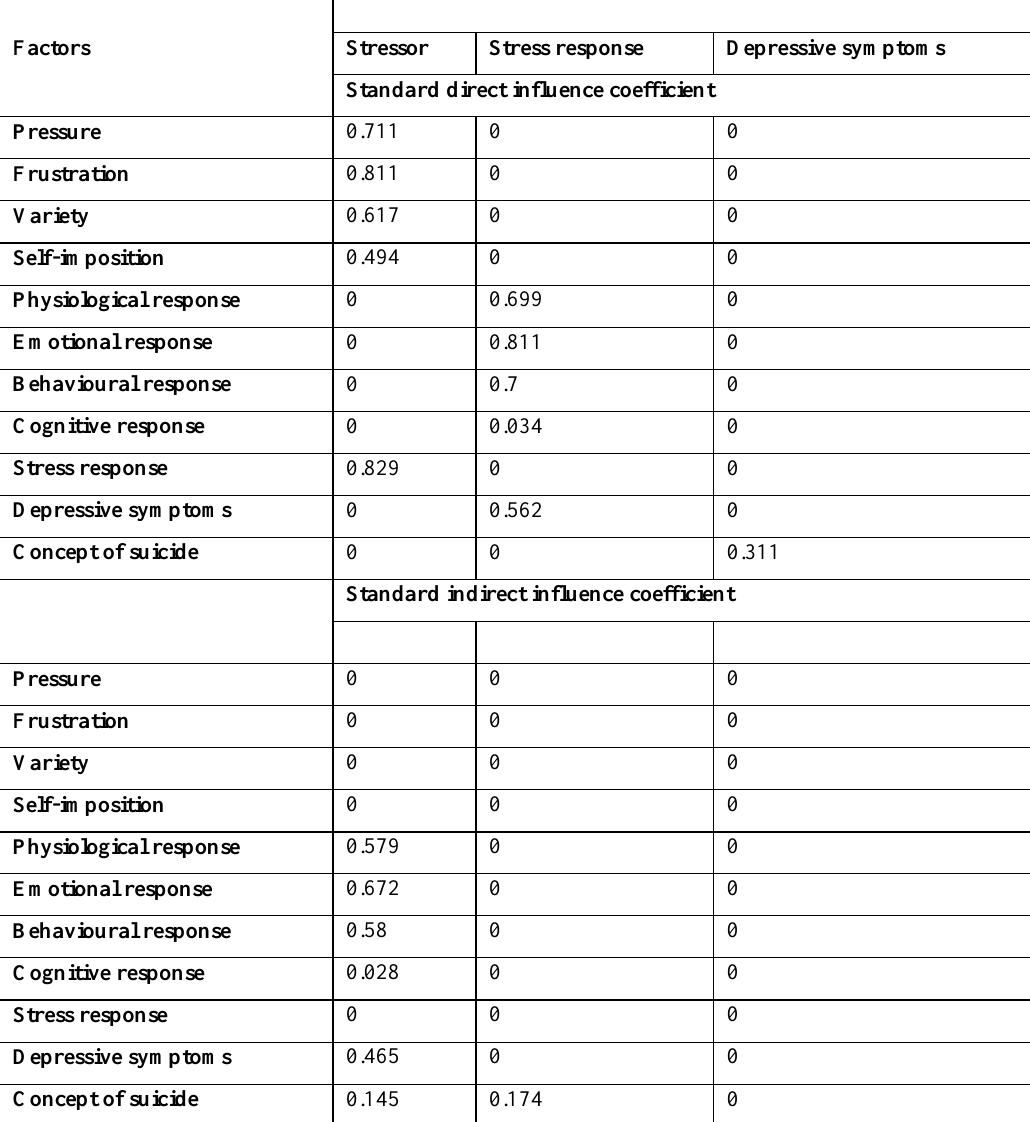
Table 5 The direct and indirect influence coefficients of various factors inducing depressive symptoms and negligence in business in the stress process of college